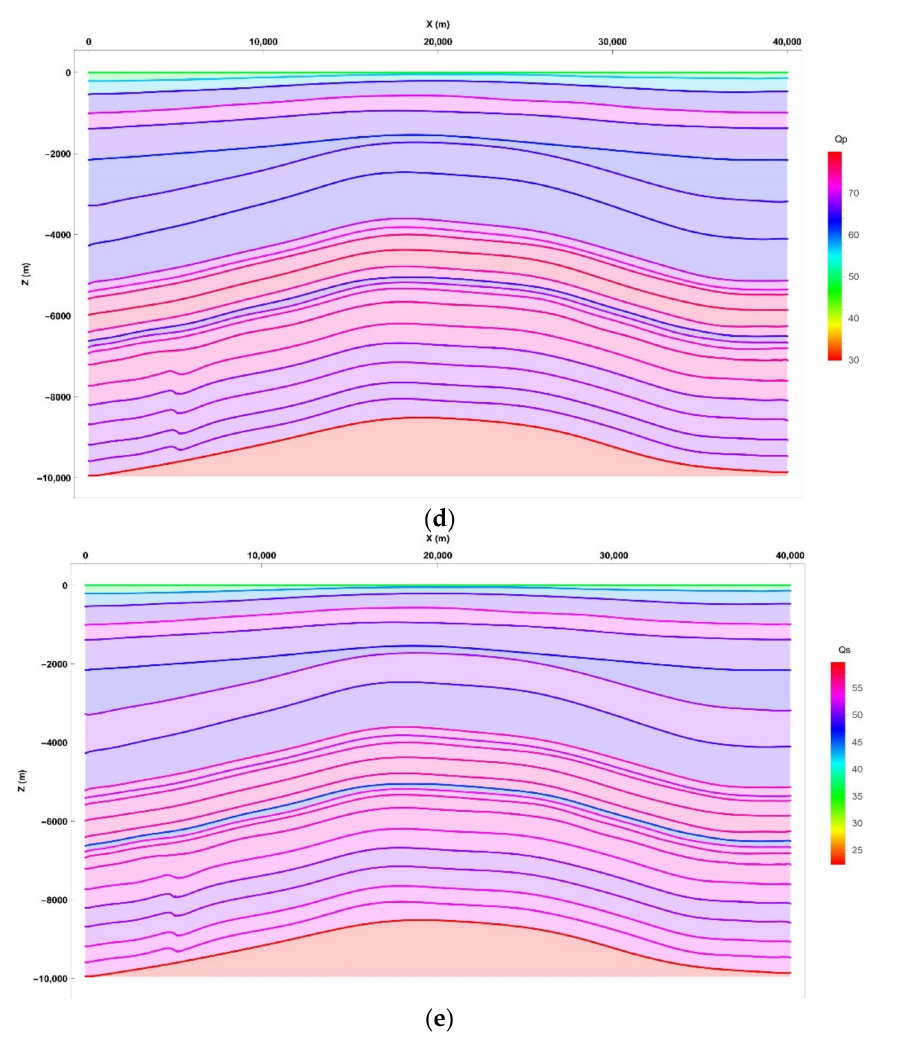
Figure 5. ( a ) Vp model; ( b ) Vs model; ( c ) density model; ( d ) Qp model; ( e ) Qs